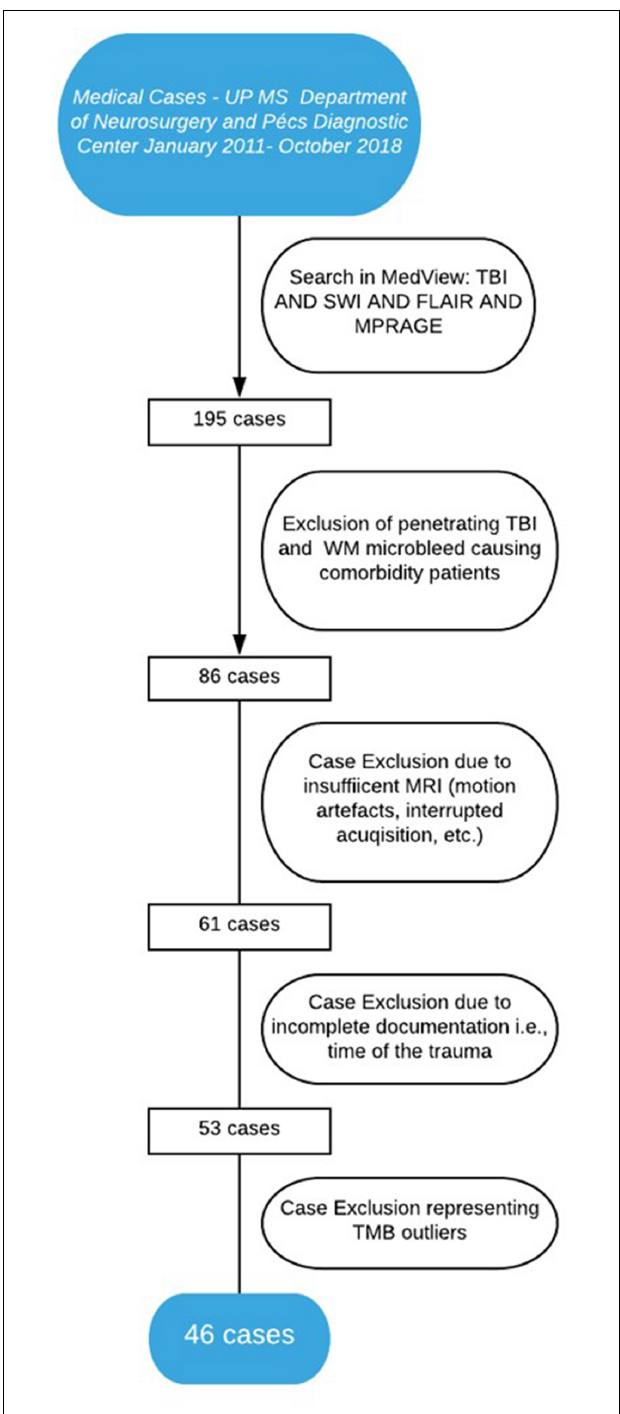
FIGURE 1 | Algorithm of patient